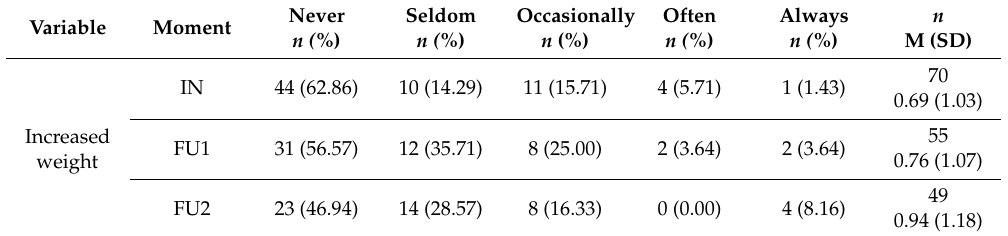
Table A1. Experienced negative health effects from smoking at intake, FU1 and